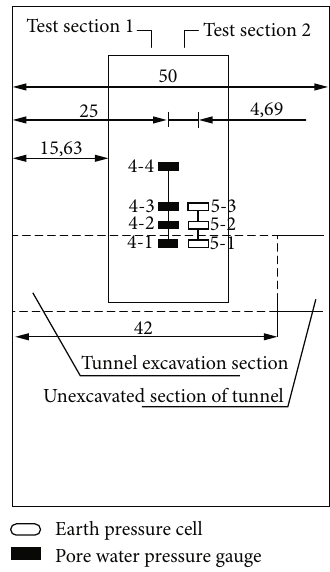
Figure 8: Design of monitoring scheme.